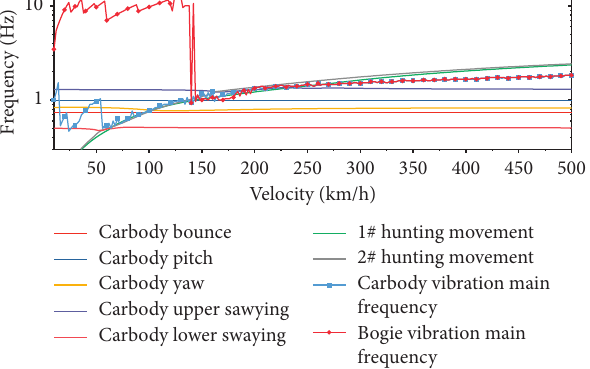
Figure 9: Vehicle vibration main frequency and carbody mode